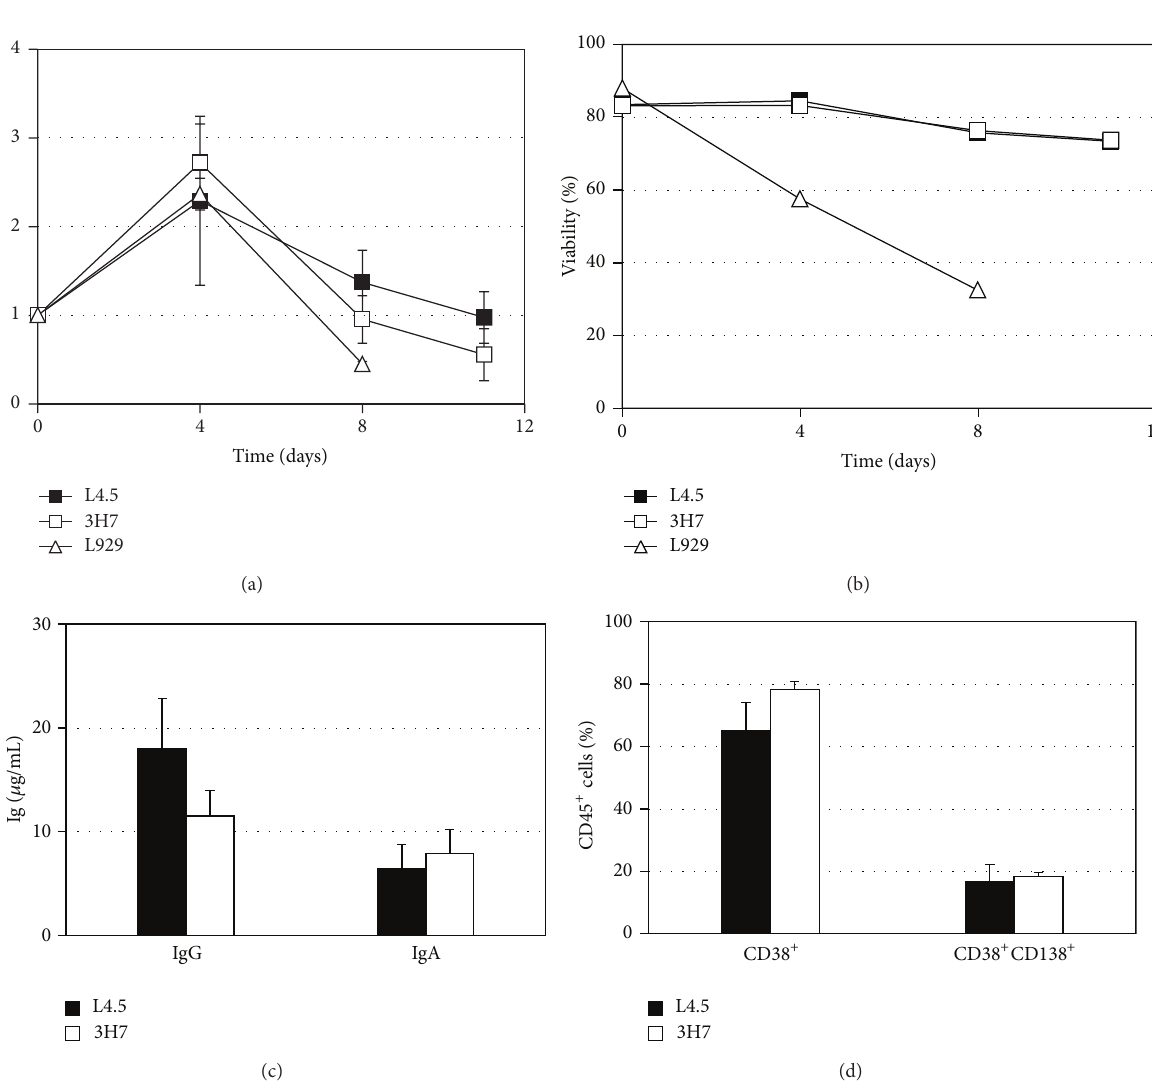
Figure 2: Proliferation and viability following low CD70 and CD154 interaction. B lymphocytes were monitored following their stimulation with CD70 and CD154 as well as for their response to the mock L929 cell line using a low ratio (1:20) for all support cells. (a) Proliferation and (b) viability were measured on days 4, 8, and 11. The time laps between days 0 and 4 are the transition phase and differentiation phase was started on day 4 and lasted until day 11. (c) Secretion of IgG and IgA was measured by ELISA assay with the pooled supernatant harvested on days 6, 8, and 11. (d) At the end of the differentiation phase (day 11), B lymphocytes were analyzed using flow cytometry to evaluate the frequency of CD38 + cells and CD38 + CD138 + cells. These results are representative of 5 independent experiments. All errors bars stand for SD and can be smaller than